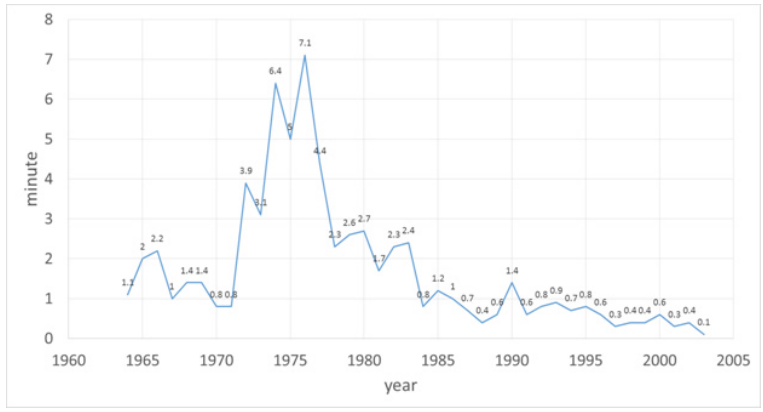
Figure 2. Average delay time per train of